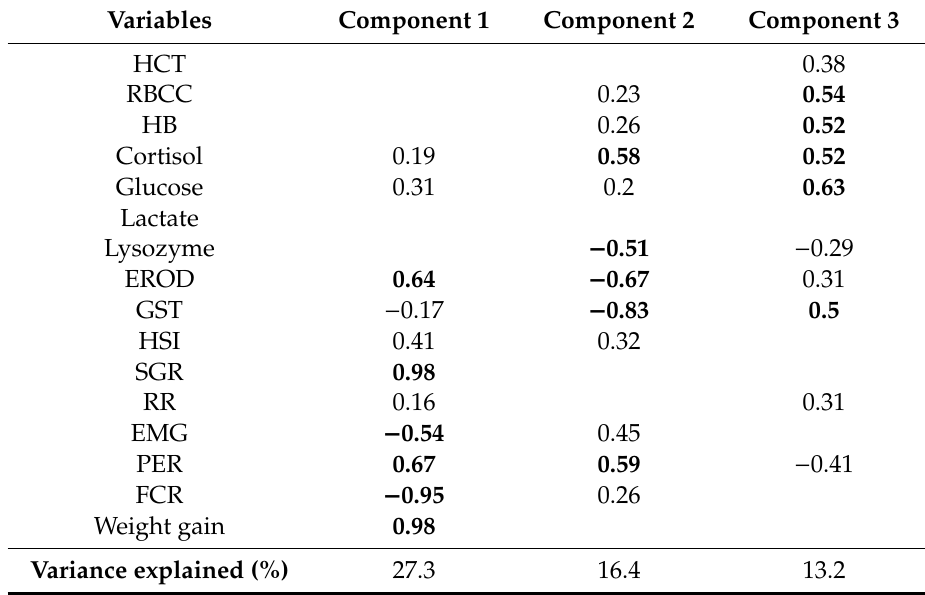
Table 5. Contribution of the sixteen variables to the di ff erent three first components of the principal component analysis (PCA) and data variance explained by each component. Only significant contributions are shown in the table ( p < 0.05). Bold indicate a contribution higher than | 0.5 |